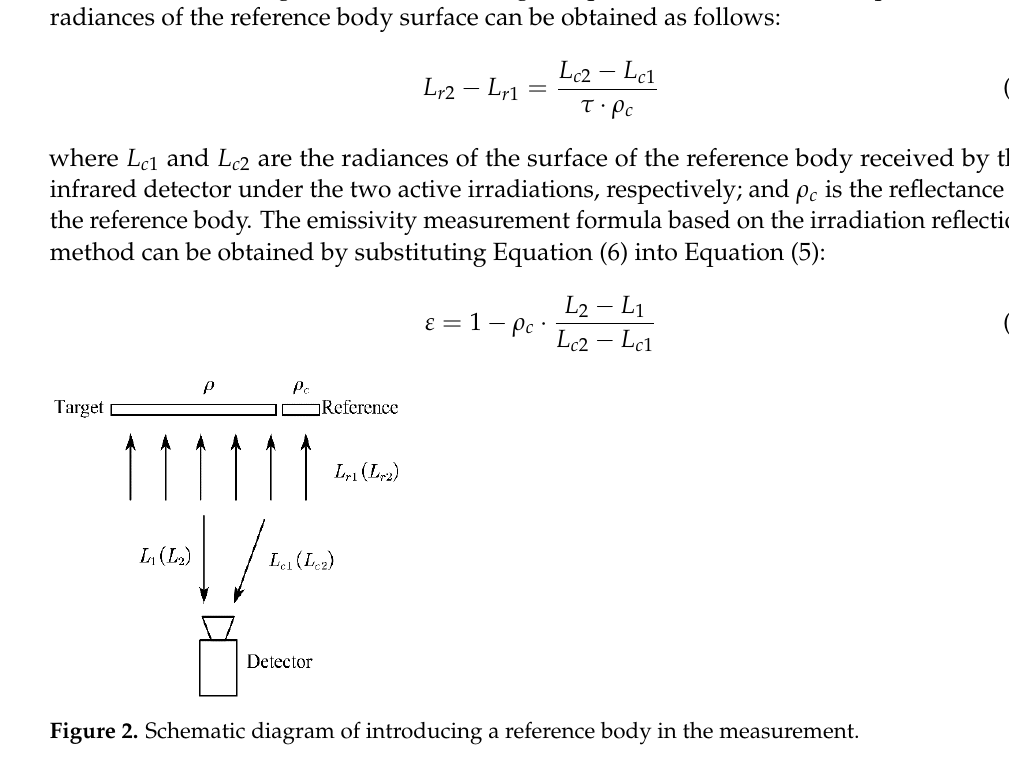
o ω . Figure 4. Radiation received by the detector from a planar object. In reality, the effects of environmental radiation, atmospheric transmittance, and atmospheric radiation need to be considered. Assuming that the environmental radiation is isotropic, as shown in Figure 5, the radiance